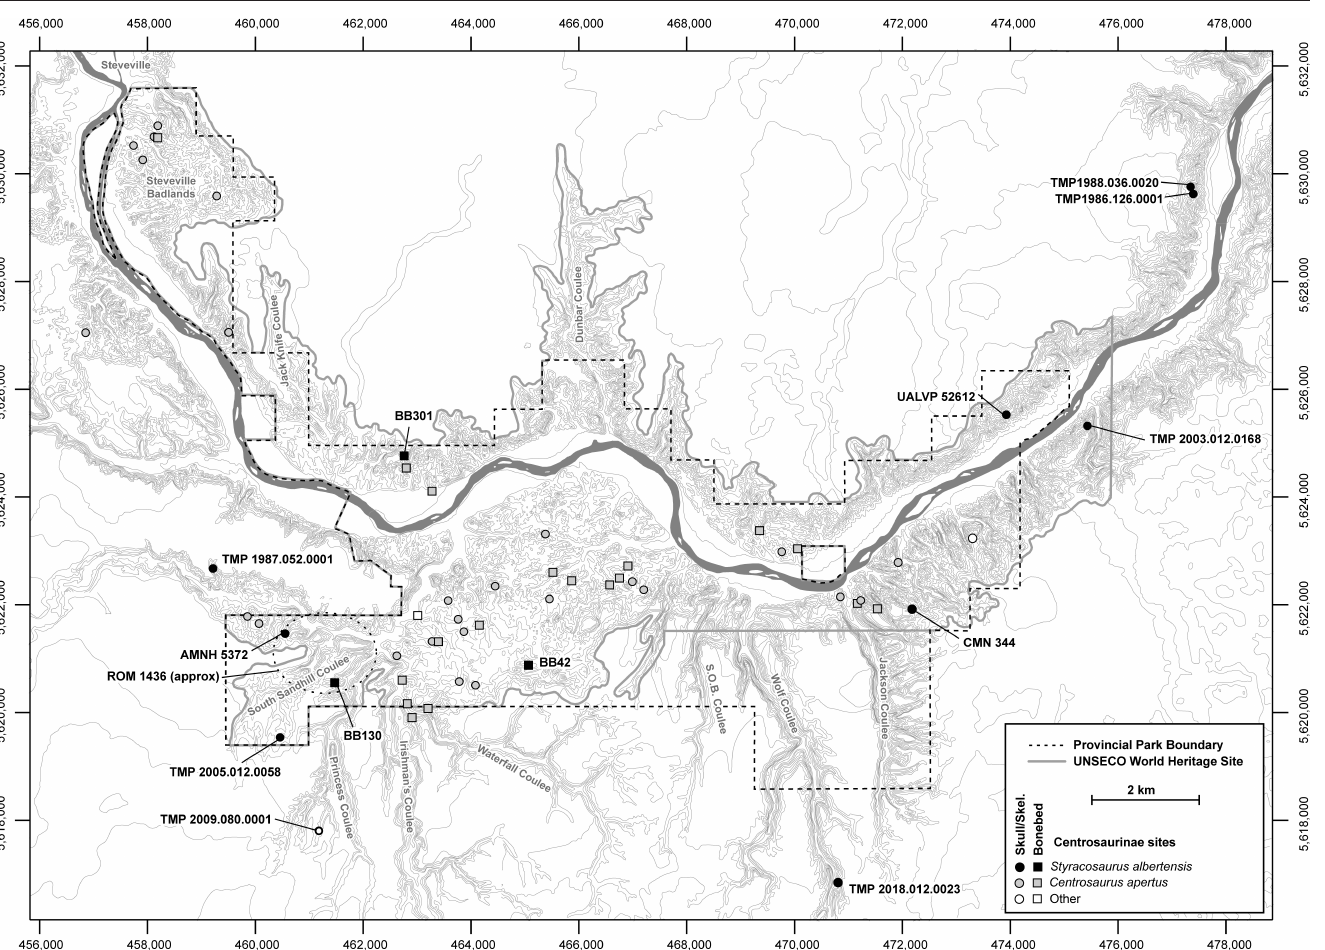
Figure 1. Map of Dinosaur Provincial Park, Alberta, illustrating the geographic localities of significant centrosaurine ceratop - sid sites (quarries and bonebeds). Styracosaurus albertensis sites (black) are specifically labelled, while those of Centrosaurus apertus (grey) and other centrosaurines (white) (e.g., Coronosaurus brinkmani , 'c.f. Pachyrhinosaurus ') are unlabelled. Circles indicate skulls and/or skeletons while squares indicate bonebeds. Hollow black circle is TMP 2009.080.0001. TMP 1989.097.0001 and UAVLP 55900 are located outside of the mapped area. UTM Coordinates (Zone 12U) are indicated in the